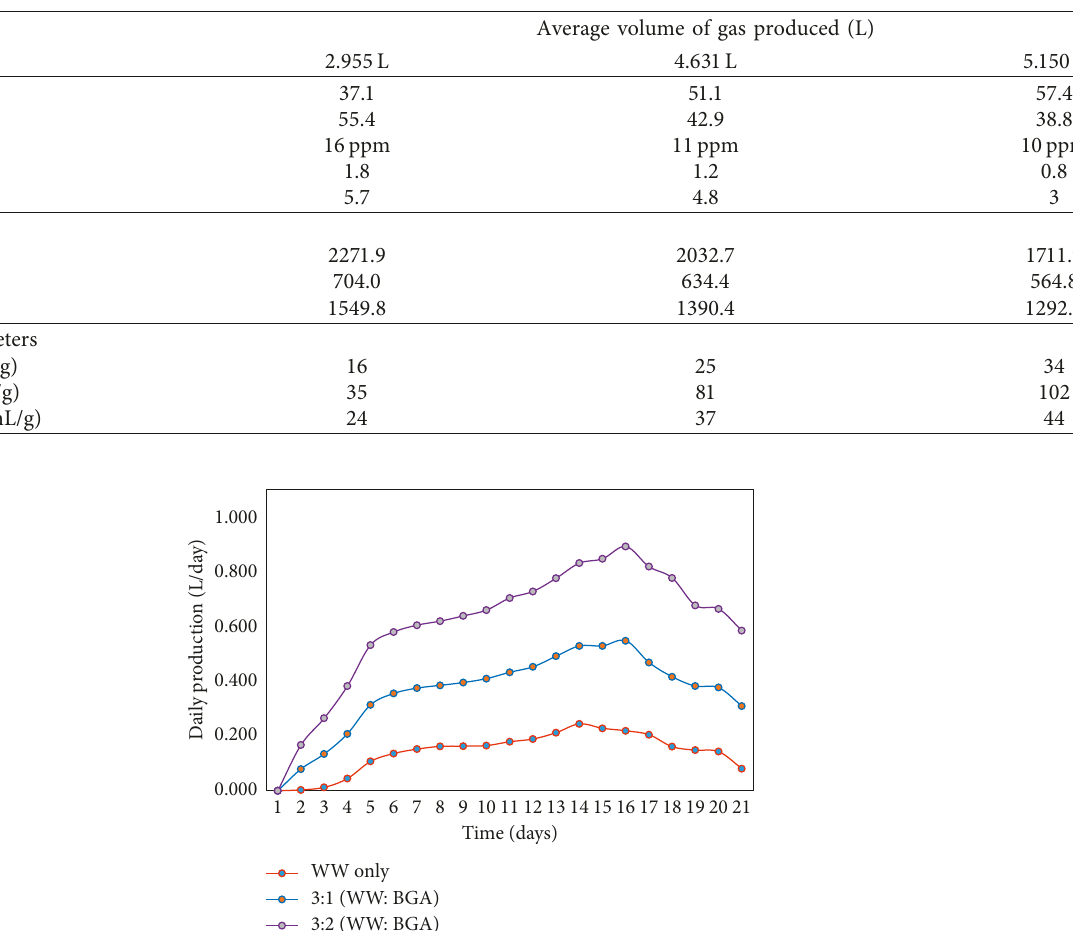
Figure 6: Relation between temperature, pH, and amount of gas produced at 3: 2 ratio (WW :MA). Table 4: Percentage composition of biogas produced.